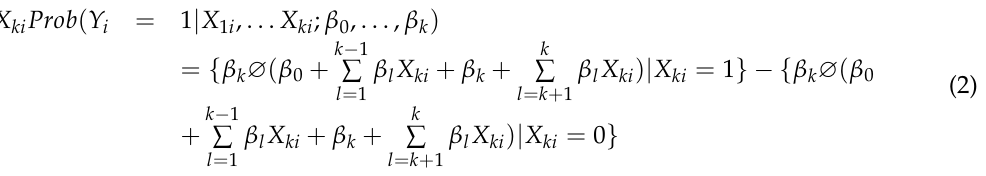
Table 3. Marginal effects for the joint probabilities of full owners and tenant farmers.